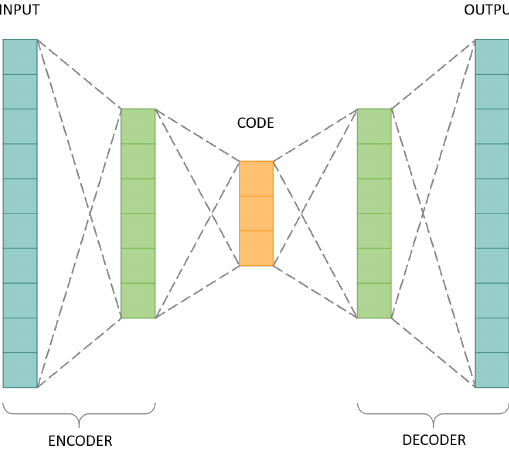
Figure 5. Typical structure of an